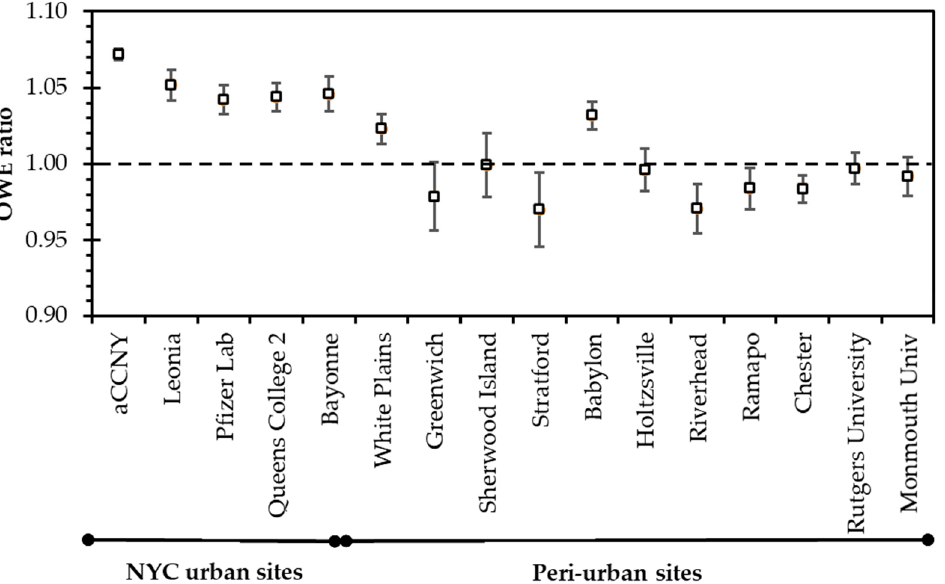
Figure 3 . The mean (±3 × standard error) ozone weekend-to-weekday effect (OWE) ratio of average maximum O 3 concentrations for each site.